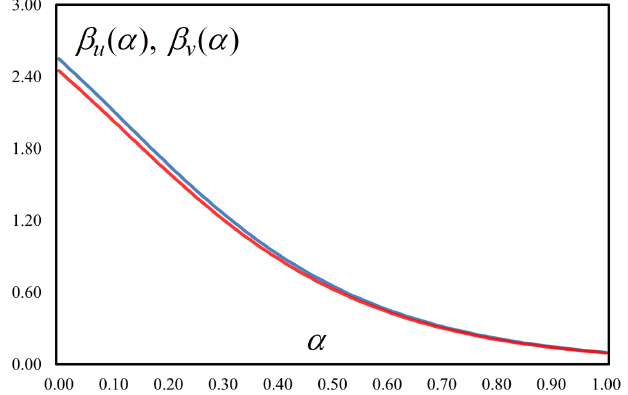
Figure 2. Option values ( β u , β v ) with convergent expectations. The x -axis corresponds to the decay parameter ( α ). The y -axis denotes the values alternative to Nash allocations ( β u ( α ) , β v ( α )